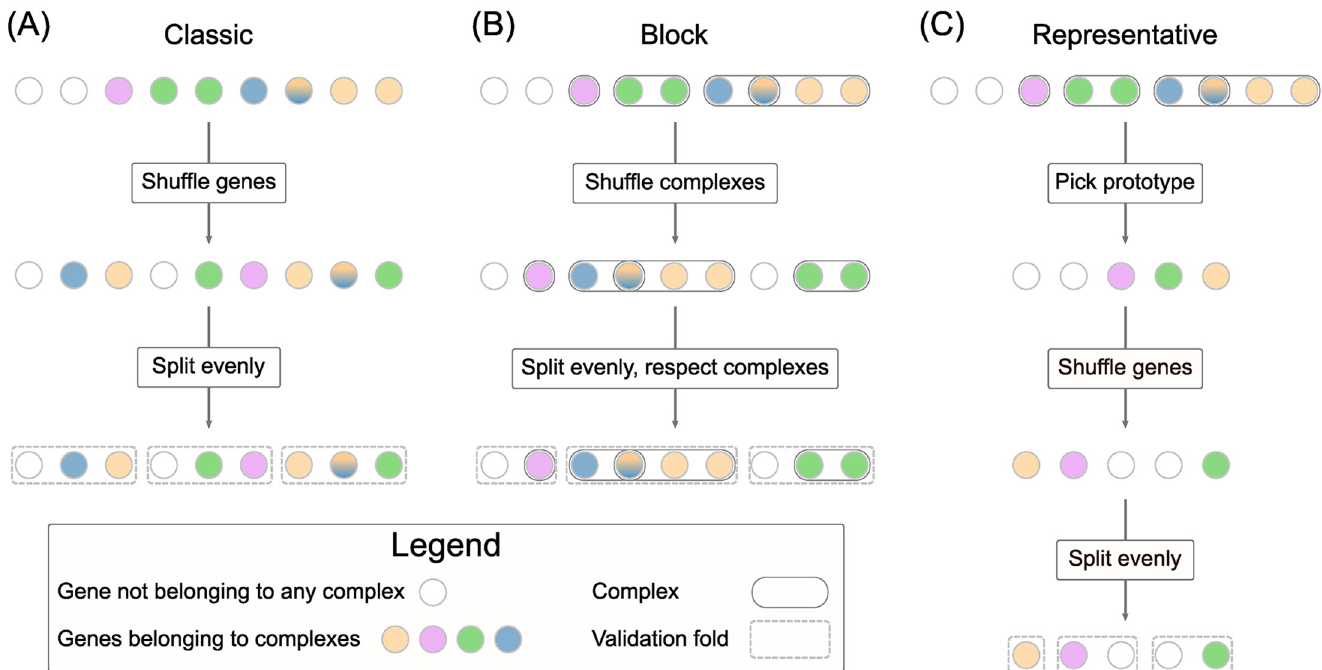
Fig 9. Cross-validation schemes. Three cross-validation schemes were tested. (A) : standard k-fold stratified cross-validation that ignored the complex structure. (B) : block k-fold cross-validation. Overlapping complexes were merged and the resulting complexes were shuffled. The folds were computed as evenly as possible without breaking any complex. (C) : representative k-fold cross-validation. Overlapping complexes were merged and the resulting complexes from which unique representatives were chosen uniformly at random. Then a standard k-fold cross-validation was run on the representatives, but excluding the non-representatives from train and